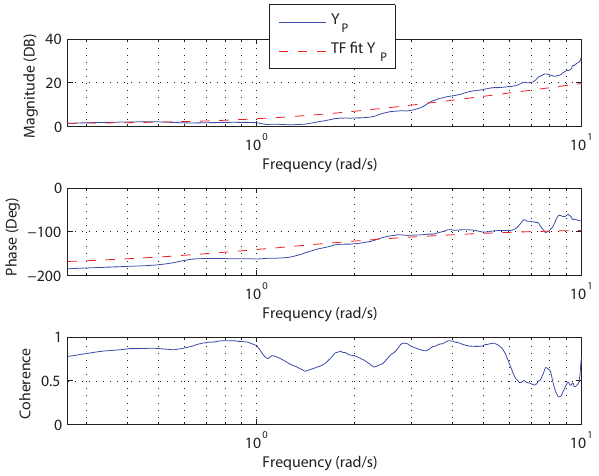
Figure 9. For the hover task, a known disturbance is injected into the control signal. The control parameters for Y P are then identified.